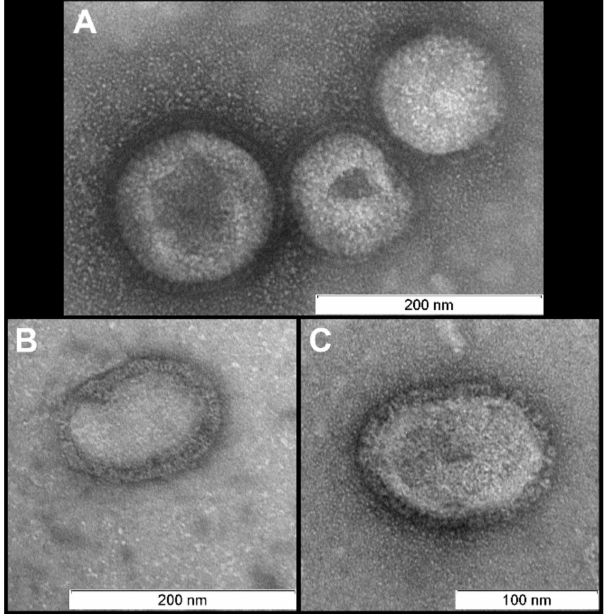
Figure 1. Virions after purification. Morphology is typical for influenza virus: near-spherical enveloped virions (diameter 100–130 nm) with spikes. Scale bar 200 nm ( A , B ) and 100 nm ( C